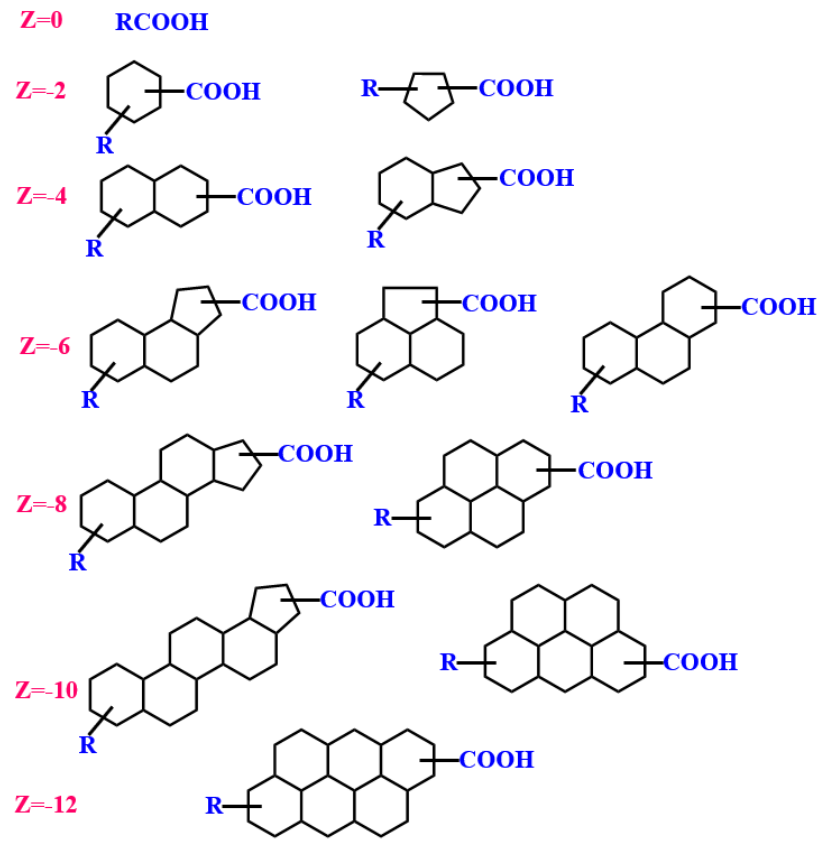
Figure 12. Typical structures of naphthenic acids with different carbon numbers and a varying degree of condensation, R represents the hydrocarbon tails. Reprinted with permission from Ref. [108]. Copyright 1991, copyright the American Chemical Society.